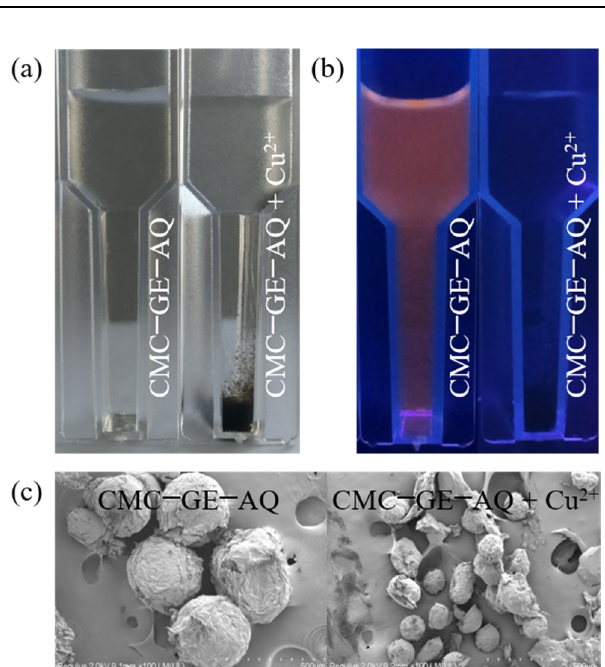
Figure 14. ( a ) Digital (visible light) and ( b ) fluorescent (365 nm) photographs and ( c ) SEM images of CMC − GE − AQ microspheres with 1.5 × 10 − 3 mol L − 1 Cu 2+ . CMC − GE − AQ microspheres were added into DMF/H 2 O ( v / v = 8/2) solution (1.5 × 10 − 4 g mL − 1 , pH = 7) with several typical metal ions and different